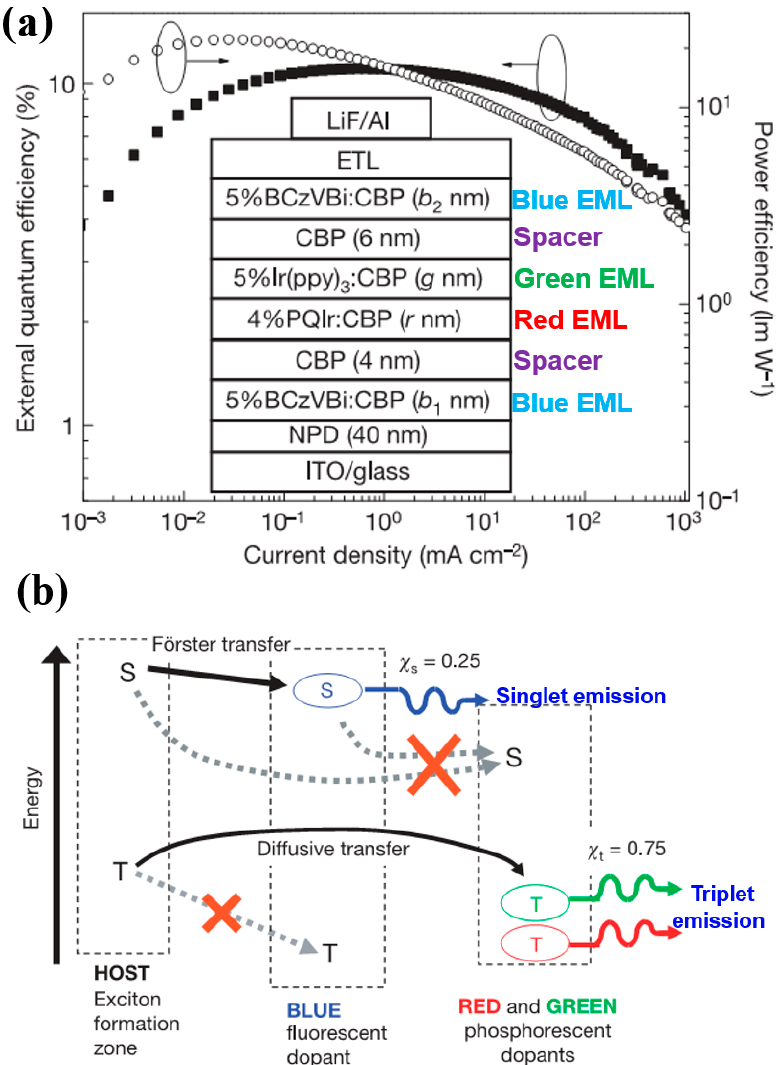
Figure 18. ( a ) The WOLED architecture and efficiency. ( b ) Diagrams of EL procedures. Reproduced from Reference [184].